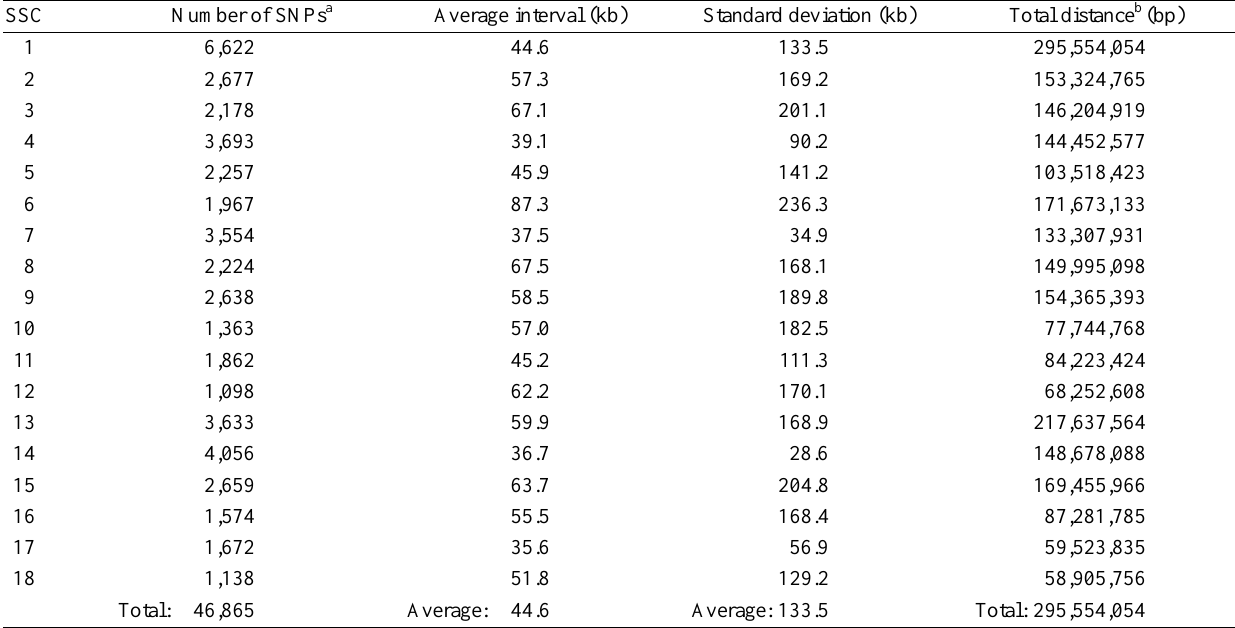
Table 2. The numbers of available SNPs in the Korean native pig and Landrace F 2 population and average interval distances between adjacent SNPs in all 18 Sus scrofa autosomes (SSC)